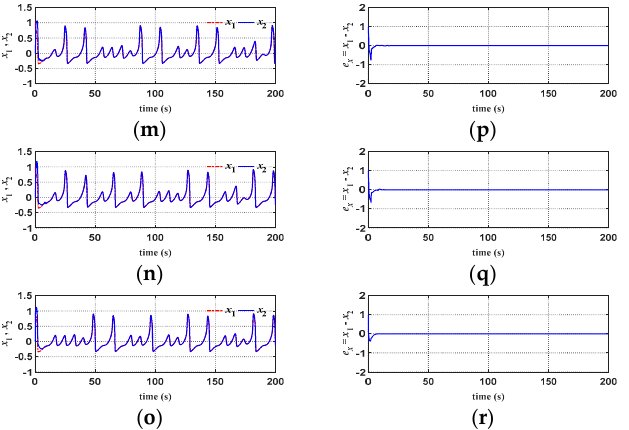
Figure 16. Comparisons on simulation results of chaotic system synchronization control ( g = 1): ( a ) Master system phase diagram for CMAC; ( b ) Master system phase diagram for FCMAC; ( c ) Master system phase diagram for ATFSORC; ( d ) Slave system phase diagram of CMAC; ( e ) Slave system phase diagram for FCMAC; ( f ) Slave system phase diagram for ATFSORC; ( g ) x 1 , x 2 phase diagram for CMAC; ( h ) x 1 , x 2 phase diagram for FCMAC; ( i ) x 1 , x 2 phase diagram for ATFSORC; ( j ) y 1 , y 2 phase diagram for CMAC; ( k ) y 1 , y 2 phase diagram for FCMAC; ( l ) y 1 , y 2 phase diagram for ATFSORC; ( m ) x 1 , x 2 response for CMAC; ( n ) x 1 , x 2 response for FCMAC; ( o ) x 1 , x 2 response for ATFSORC; ( p ) Error e x for CMAC; ( q ) Error e x for FCMAC; ( r ) Error e x for ATFSORC.